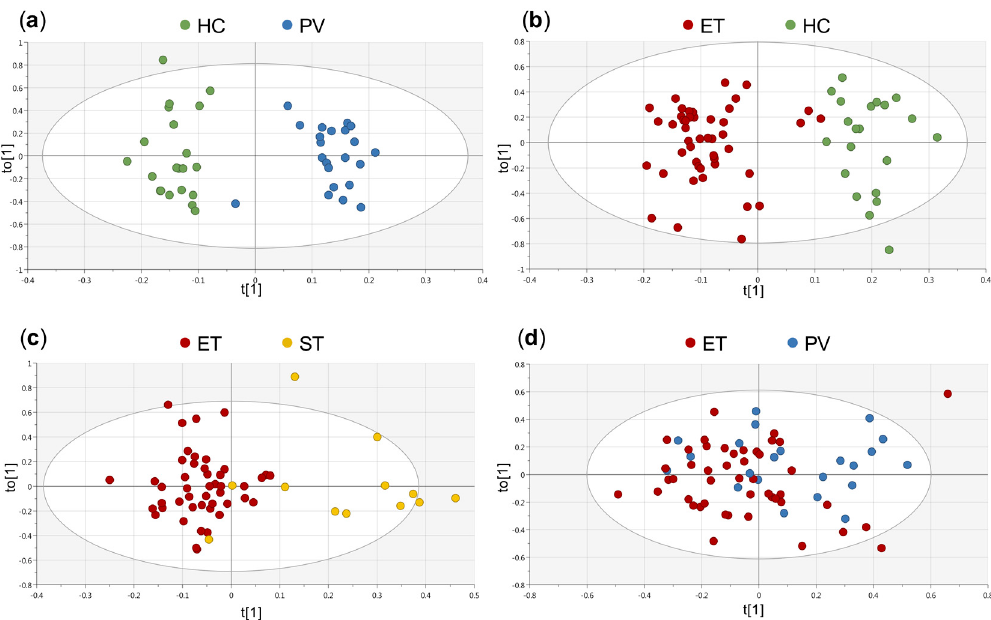
Figure 1. Orthogonal partial least squares discriminant analysis (OPLS-DA) scores showing the separation between the groups of study. ( a ) healthy controls (HC) ( • ) vs. polycythemia vera (PV) ( • ): R 2 Y = 0.909, Q 2 Y = 0.721, ( b ) HC ( • ) vs. essential thrombocythemia (ET) ( • ): R 2 Y = 0.82, Q 2 Y = 0.747, ( c ) ET ( • ) vs. secondary thrombocytosis (ST) ( • ): R 2 Y = 0.641, Q 2 Y = 0.463 and ( d ) PV ( • ) vs. ET ( • ): R 2 Y = 0.175, Q 2 Y = − 0.0943. HC: healthy control, PV: polycythemia vera, ET: